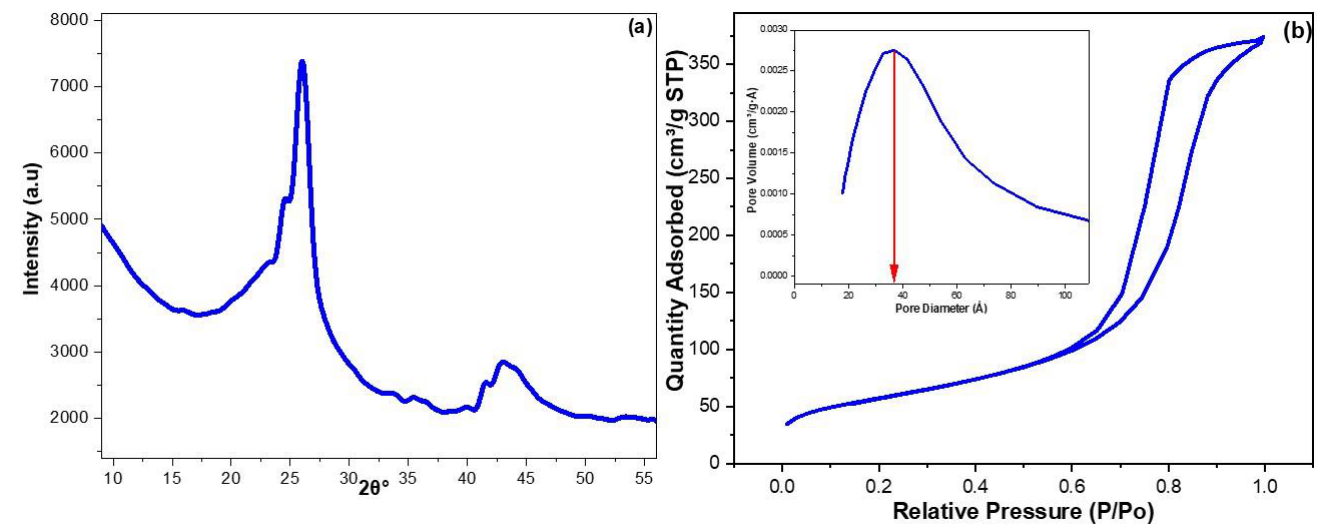
Figure 2. ( a ) XRD pattern for the fabricated CRNPs; ( b ) surface analysis of the CRNPs using the nitrogen adsorption-desorption isotherm. nitrogen adsorption-desorption